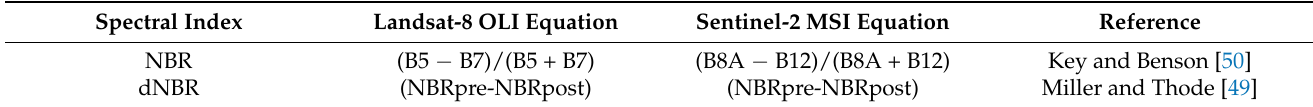
Table 2. Burn severity spectral indices.